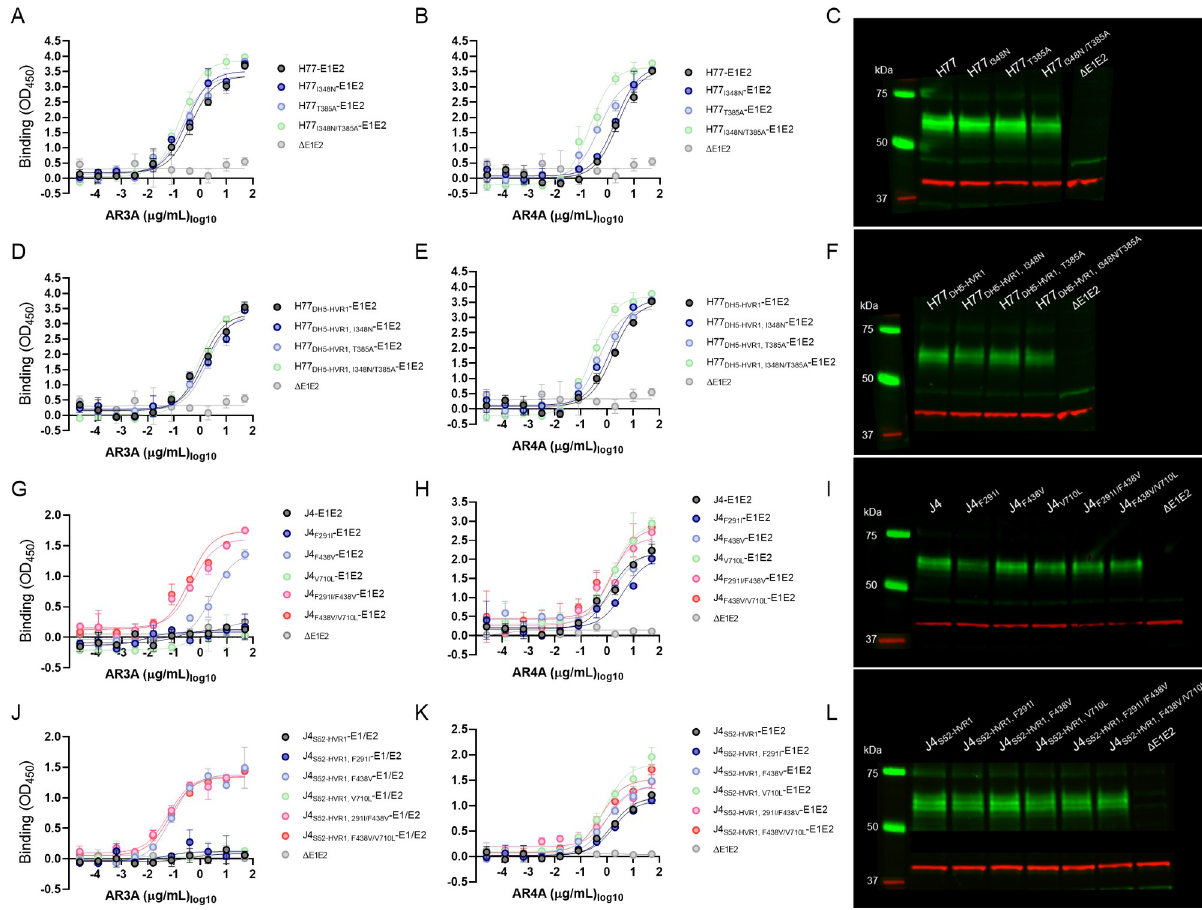
Fig 9. HVR1 swaps and associated adaptive envelope mutations have divergent effects on antibody binding to extracted E1/E2 protein. (A-B, D-E, G-H and J-K) Binding curves for dilution series of monoclonal antibodies (mAbs) AR3A and AR4A in ELISA to the indicated extracted E1/E2 proteins. Cell lysates containing E1/E2 protein were added to lectin-coated ELISA plates and incubated overnight. mAbs were added in 5-fold dilution series for a 2-hour incubation. The binding was detected with an HRP-conjugated anti-human IgG secondary antibody. TMB Stabilized Chromagen substrate (Thermo Fisher Scientific) was added, and absorbance was measured at 450 nm. Each data point represents a mean of two technical replicates with error bars representing standard derivation. The data was analysed using three-parameter nonlinear regression using Graphpad Prism v8.0.0. The data shown is a representative experiment out of at least 2. (C, F, I and L) Quantification of E2 protein in collected cell lysates. Equivalent volumes of the cell lysates used in panels A-B, D-E, G-H and J-K were run on SDS-PAGE, and E2 protein was visualized in a fluorescent western blot using the mAb, AP33. β - actin was visualized as a loading control. Δ E1E2 is the negative control plasmid without the HCV envelope protein sequence